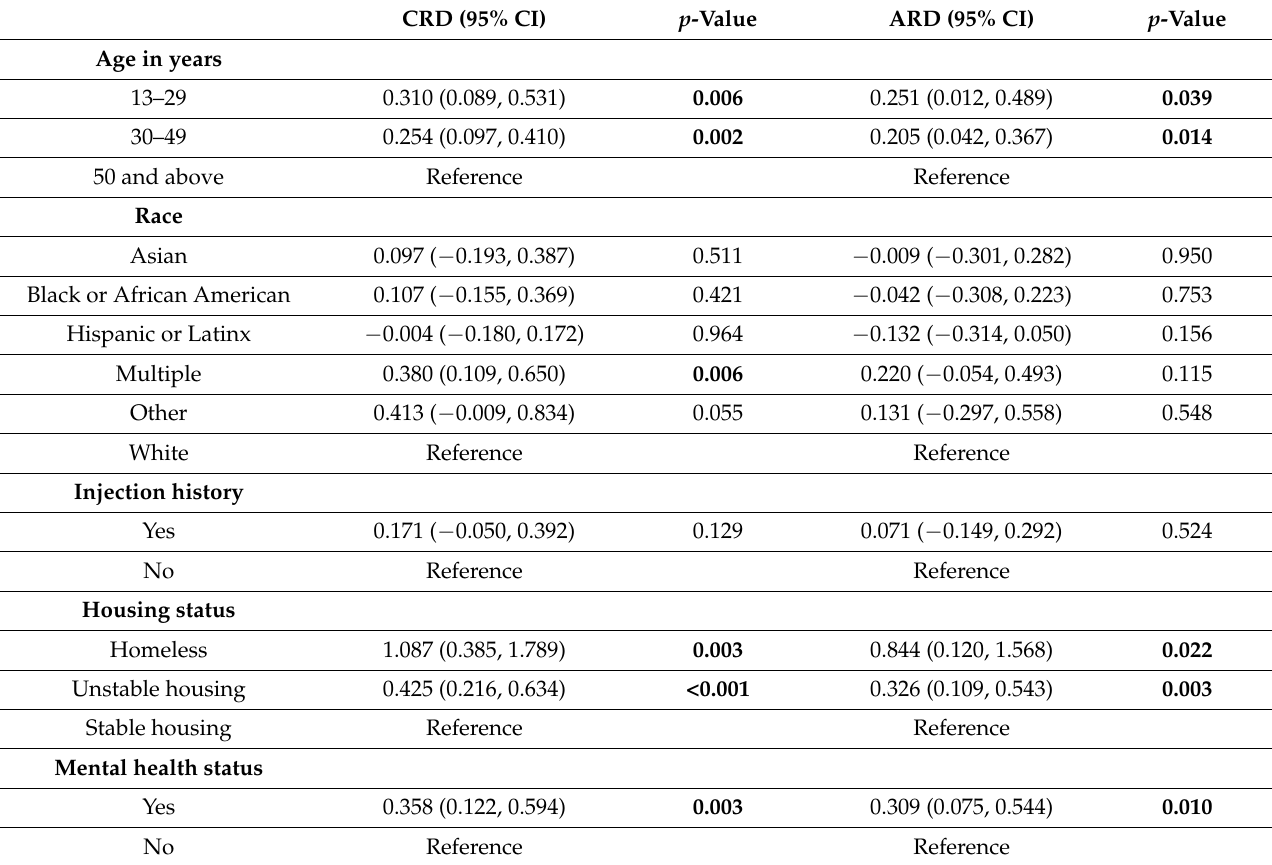
Table 3 shows relationships between HIV stigma and background characteristics. In unadjusted regression analyses, age, housing status and mental health status were significantly associated with HIV stigma. After controlling for age, race, injection history, housing, mental health status and viral load, HIV stigma was significantly higher for the age groups of 13–29 years (adjusted risk difference (ARD): 0.251, 95% CI: 0.012, 0.489) and 30–49 years (ARD: 0.205, 95% CI: 0.042, 0.367) when compared to the age group of 50 years and older. The participants who reported being homeless (ARD: 0.844, 95% CI: 0.120, 1.568) and having unstable housing (ARD: 0.326, 95% CI: 0.109, 0.543) experienced significantly higher HIV stigma than those who had stable housing. The participants who reported mental health concerns (ARD: 0.309, 95% CI: 0.075, 0.544) had higher HIV stigma ratings than those who did not. Table 3. Association between individual characteristics and HIV